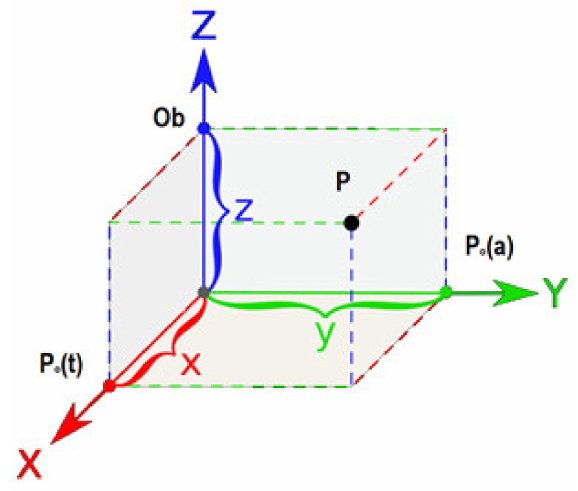
Figure 2. Condition space model of the personalized medical data.